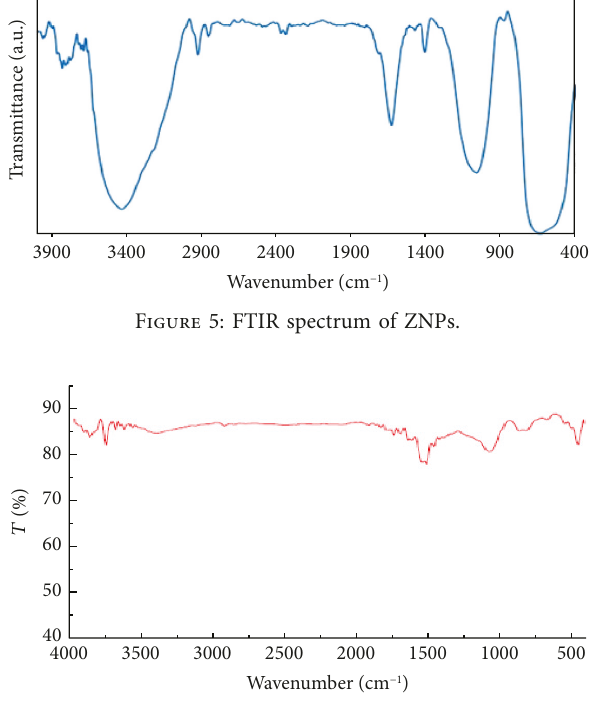
Figure 6: FTIR spectrum of the activated carbon from maize cobs.